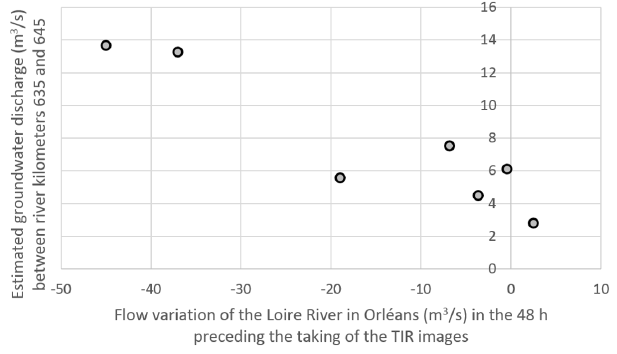
Figure 7. Groundwater discharge rate as a function of the variation in river flow in the 48h before the TIR image was taken.